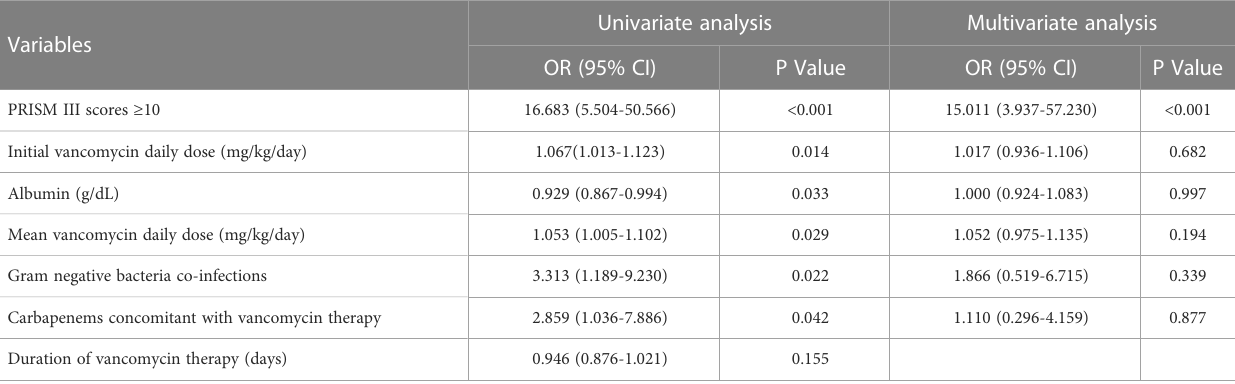
TABLE 3 Logistic analysis of risk factors for treatment